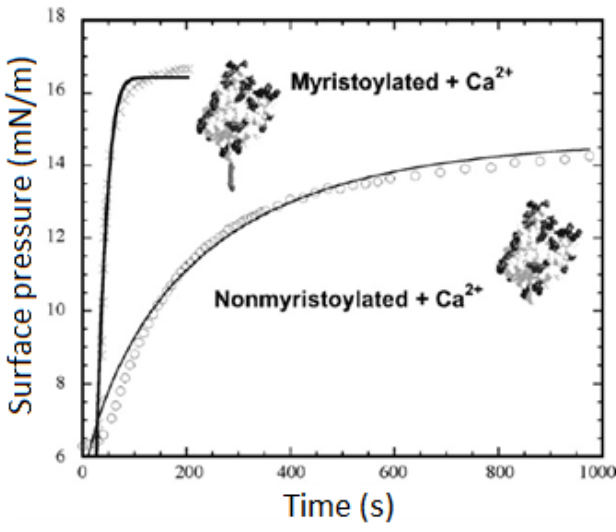
Figure 2. Π – t adsorption isotherms of myristoylated and nonmyristoylated recoverin adsorb onto a dimyristoyl phosphatidylcholine monolayer